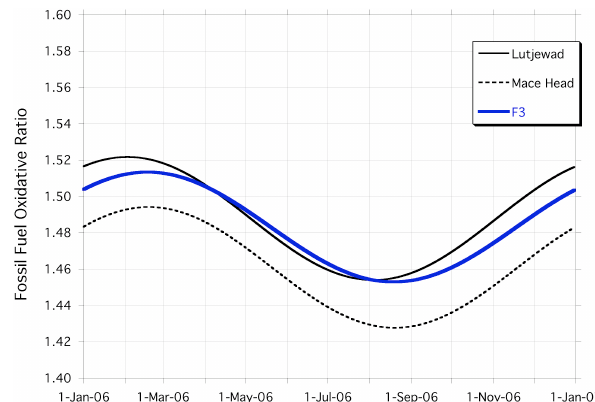
Fig. 7. Fit of the modelled data of fossil fuel CO 2 and O 2 for 2006 expressed as the perceived fossil fuel oxidative ratio (OR) for our three measurement locations using REMO. The fit shows the seasonal variability in the average OR for each location during the course of the year as well as the spatial variability between the three sites. The OR at all sites differs significantly from the global mean OR of 1.4 as well as from its local emission based OR (EDGAR) as shown in Fig. 2a.